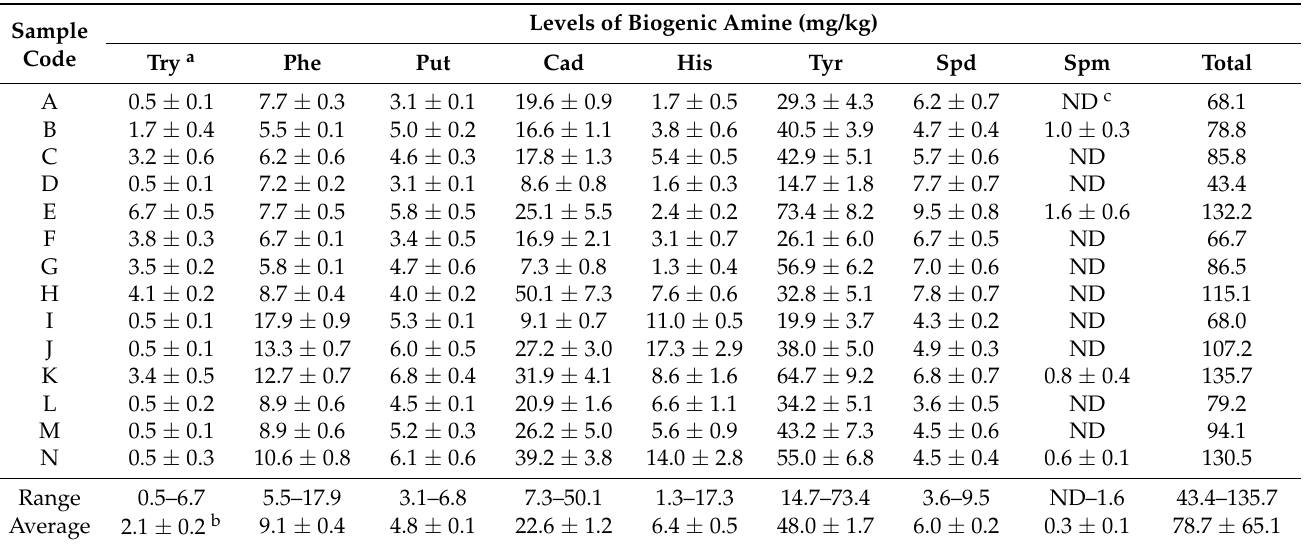
Table 3. Level of biogenic amines in mustard pickle products from retail